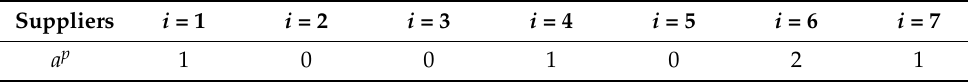
Table 3. Level of flexibility in the delivery time of each